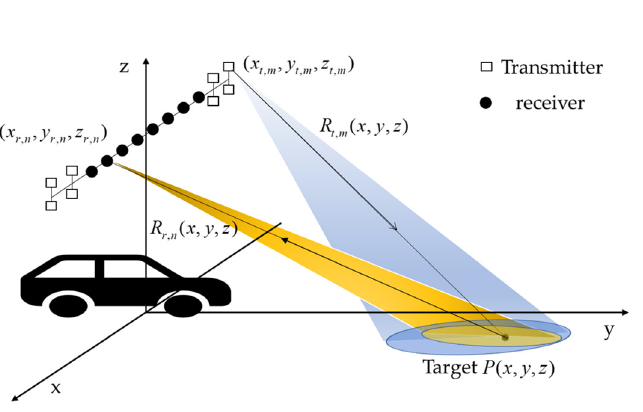
Figure 1. Imaging geometry of MIMO Radar.